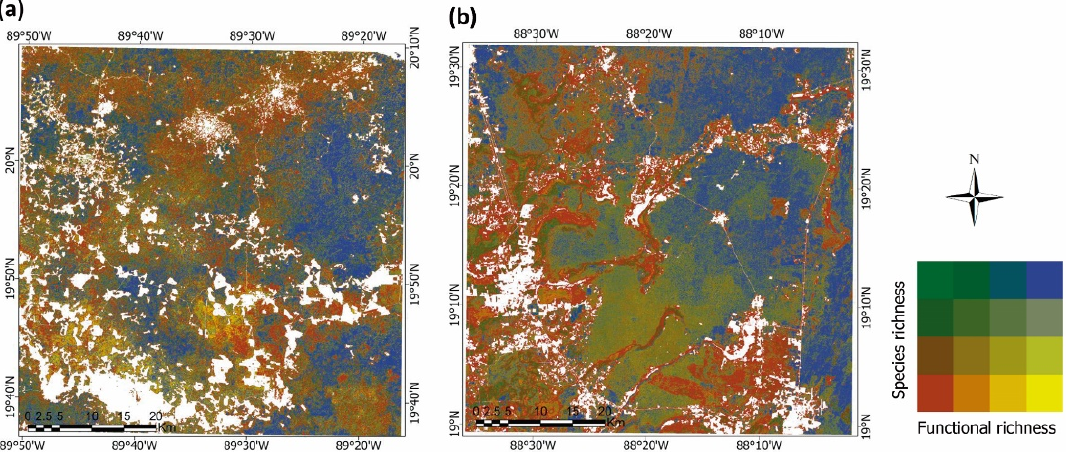
Figure 6. Maps showing the relationships between tree species richness and functional richness for the tropical semi-deciduous forest ( a ) and the tropical semi-evergreen forest ( b ).